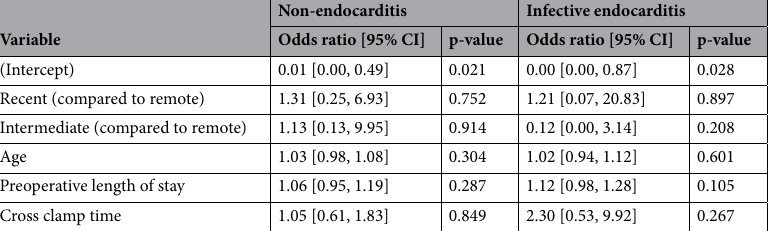
Table 5. Multivariable logistic regression analysis of variables selected based upon results of backwards stepwise regression, boosted tree model, and random forest model. CI confidence interval.